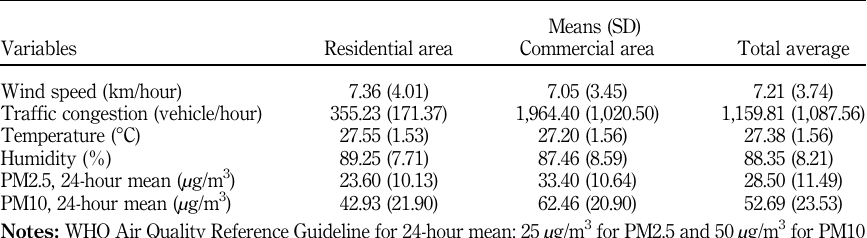
Table I. Overall status of the variables for the whole